Question: What form of chart is displayed?
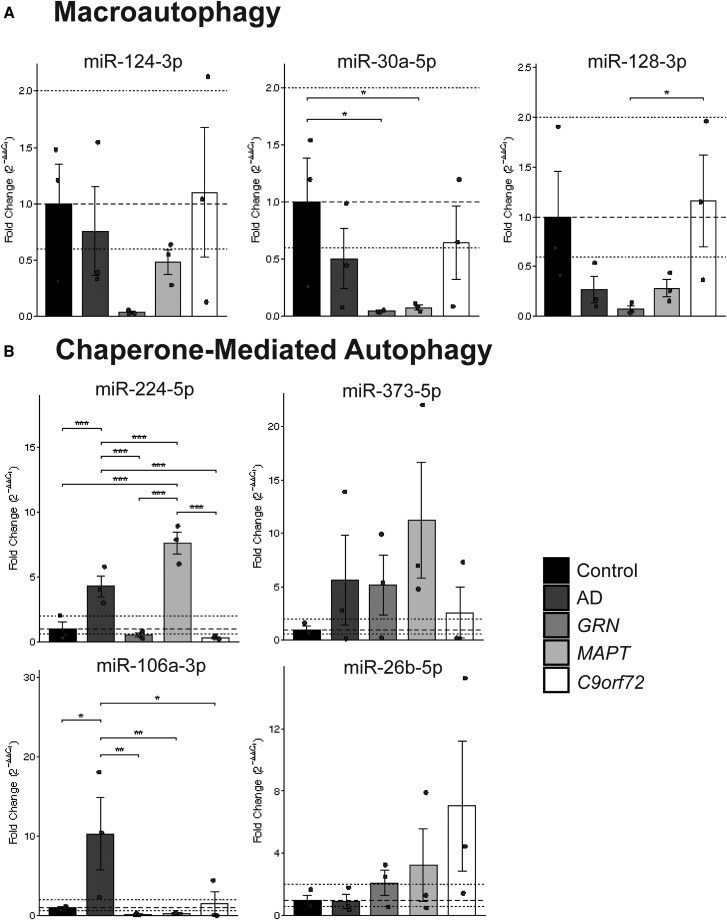
Answer: bar